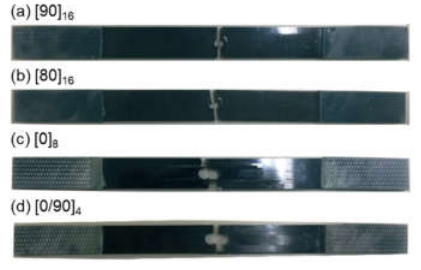
Figure 2. Carbon-fiber-reinforced plastic specimen after tensile testing.